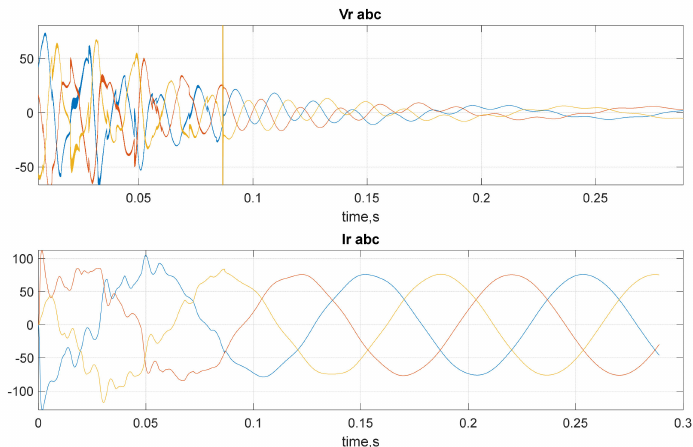
Figure 28. Waveforms of rotor phase voltages V r and rotor currents I r for protection a.